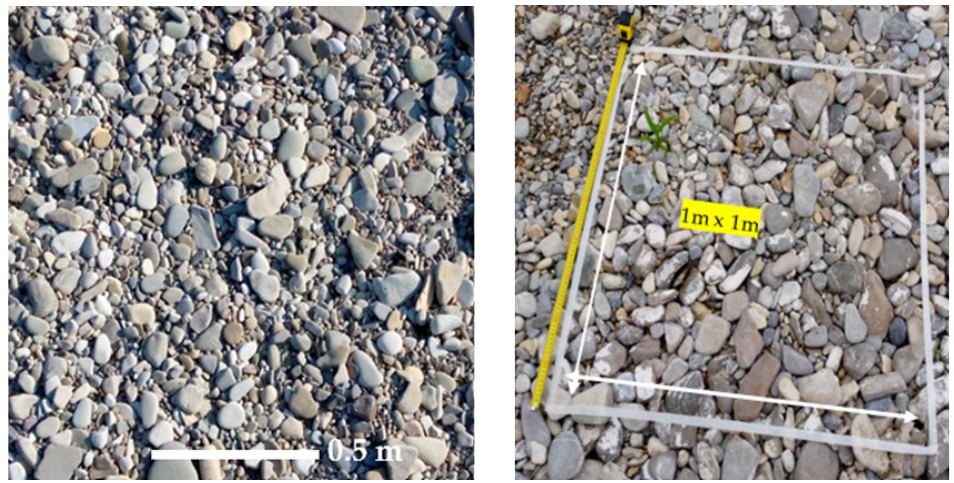
Figure 2. Digital photographs of the Baganza streambed taken for the grain size analysis using Digital Gravelometer.